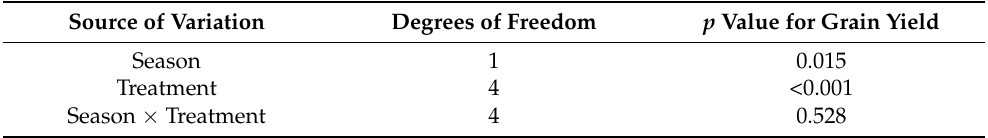
Table 4. Summary of the effect of season (main plot), treatment (sub-plot) and their interaction on finger millet grain yields over two cropping seasons (2015/16 and 2016/17) in on-farm trials in Hwedza, semi-arid